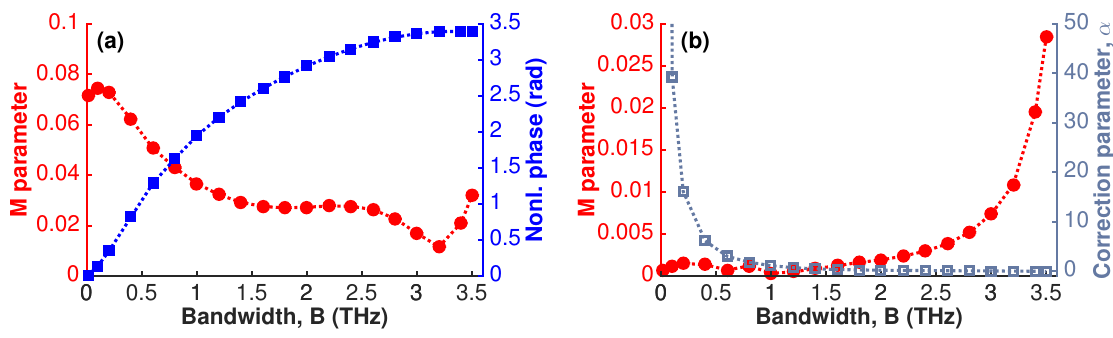
Figure 5. Misfit parameter to a sinc shape at the output of the laser (red circles) versus filter bandwidth B for ( a ) a flat-top and ( b ) a Gaussian-top spectral pulse shaper and a laser without in-cavity dispersion control. The evolutions of the peak nonlinear phase shift (blue squares) and the correction factor α (grey open squares) are also shown. Adapted from